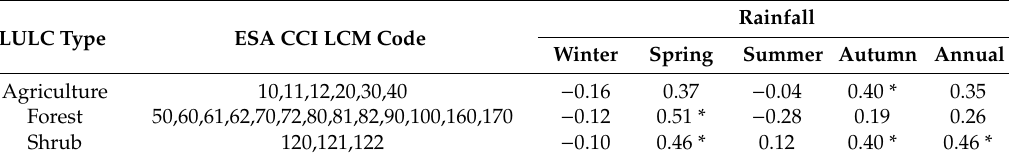
Table 3. The correlation between ASM and rainfall over the major land use land cover classes of the UBNB.